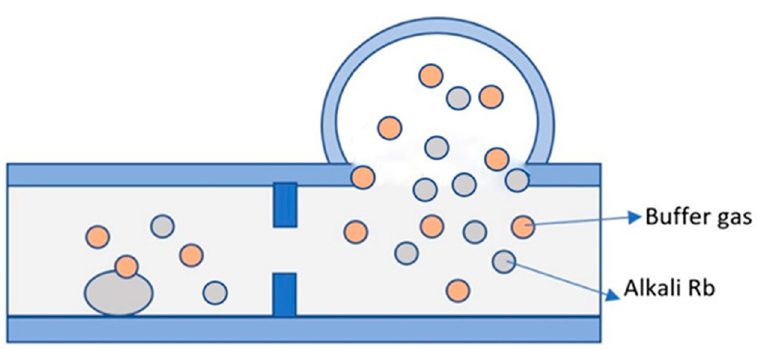
Figure 8. A schematic cross-sectional view of the micro-cells equipped with one spherical chamber and one planar chamber. The two cells are designed with the same volume of approximately 6 mm 3 .